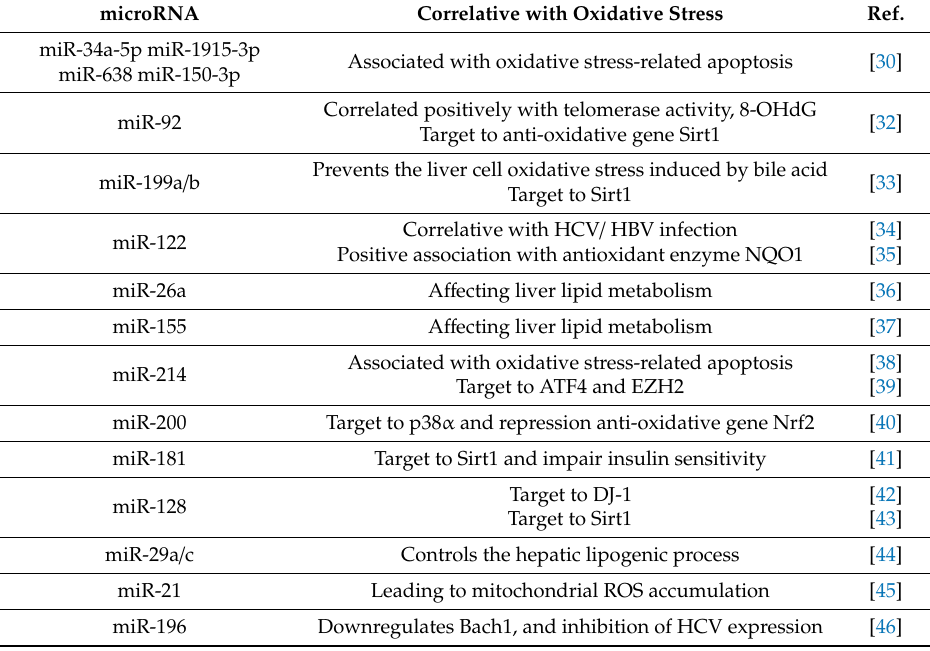
* Potential functions of miRNAs related to oxidative